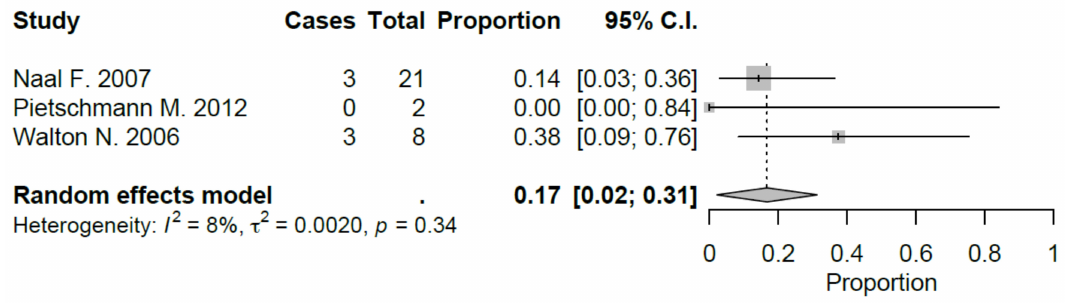
Figure 8. Return to tennis after UKA (C.I.: Confidence